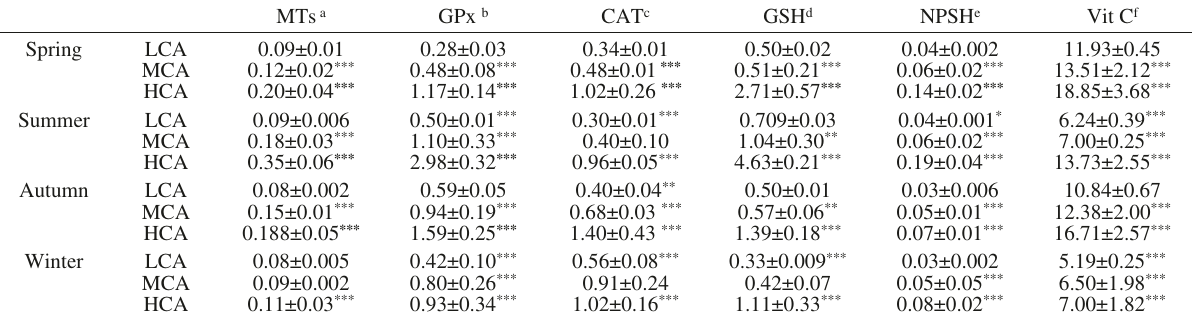
Table 3. – Mean (±SD) biomarker responses in R. decussatus from Tunisian coast: Ghar el Melh (LCA), the North Lake (MCA) and the South Lake (HCA). MTs, metallothioneins; GPx, glutathione peroxidase; CAT, catalase; GSH, glutathione; NPSH, non-protein SH; Vit C, vitamin C. Values are expressed as means±SD (n=30). Significant differences are determined at 0.05 using two-way ANOVA: *p<0.05, **p<0.01; ***p<0.001; a, nmol of GSH/ mg protein; b, nmol of GSH/min/mg protein; c, µmol/min/mg of protein; d, µg/mg protein; e, µmol of GSH/mg protein; f: nmol/mg protein.